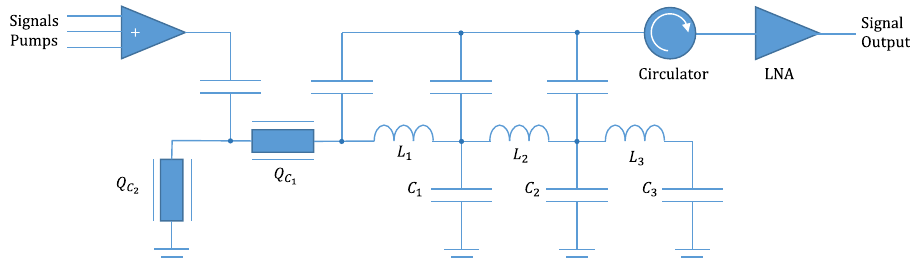
Fig. 3 Proposed nonlinear circuit for the Field-Programmable Capacitor Array